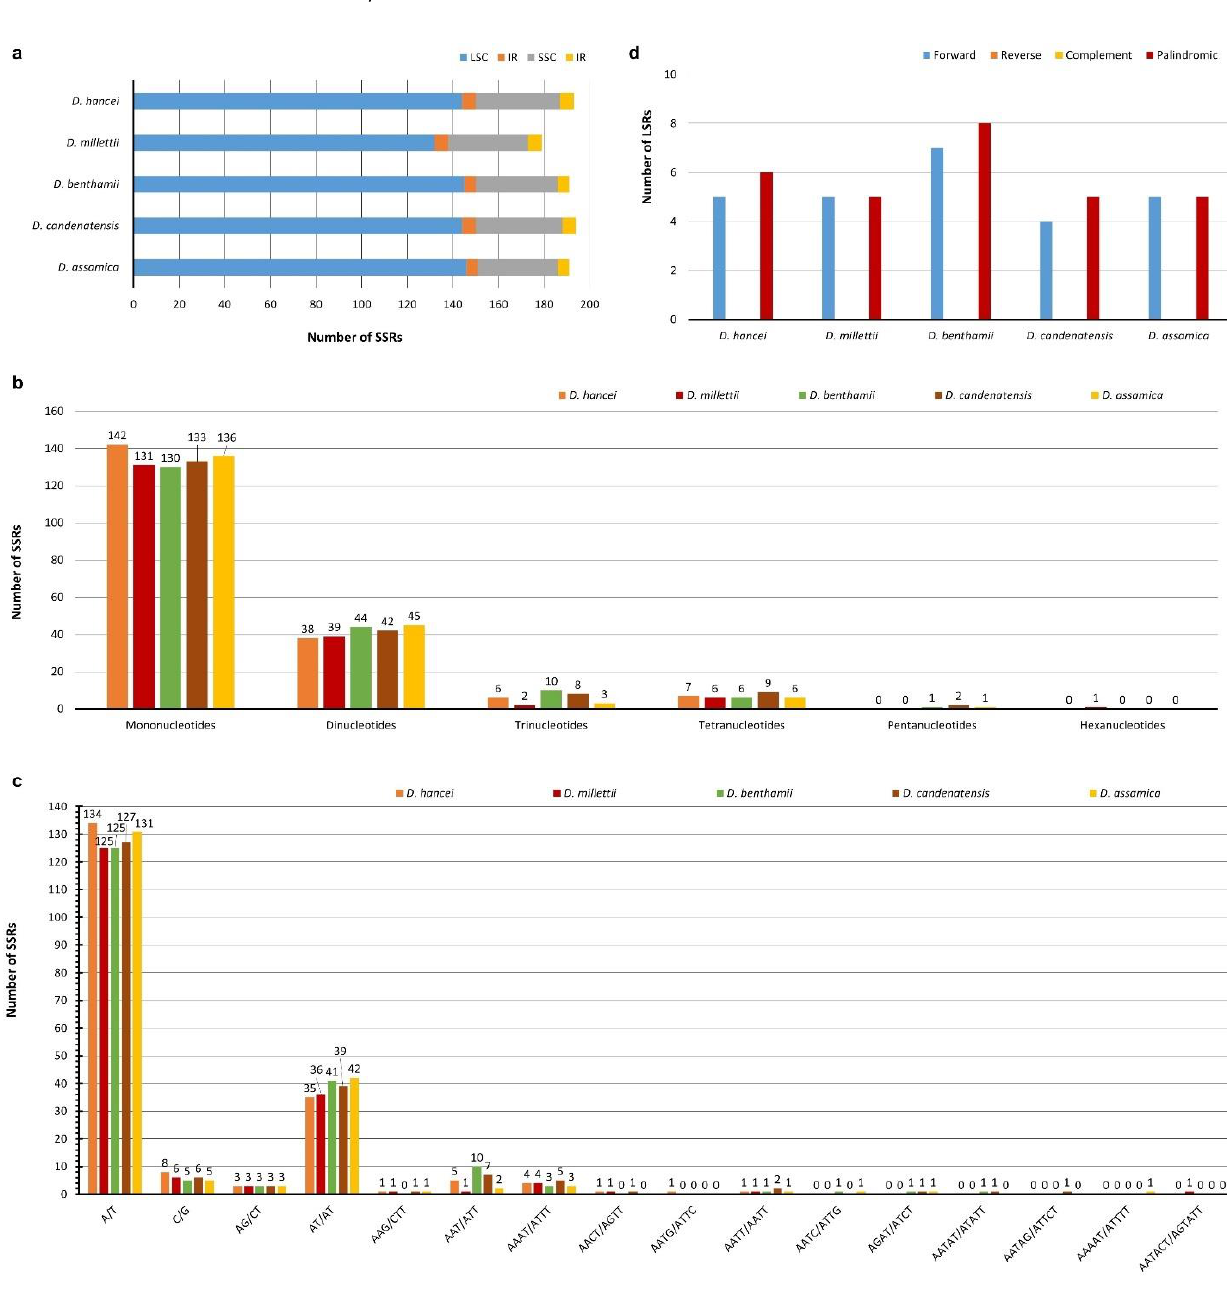
Figure 2. Analysis of repeats in the five Dalbergia chloroplast genomes. ( a ) Number of SSRs in different regions of Dalbergia cp genomes. ( b ) Frequency of SSRs classified by the types of repeats. ( c ) Frequency of different SSR motifs. ( d ) Number of different types of long sequence repeats.